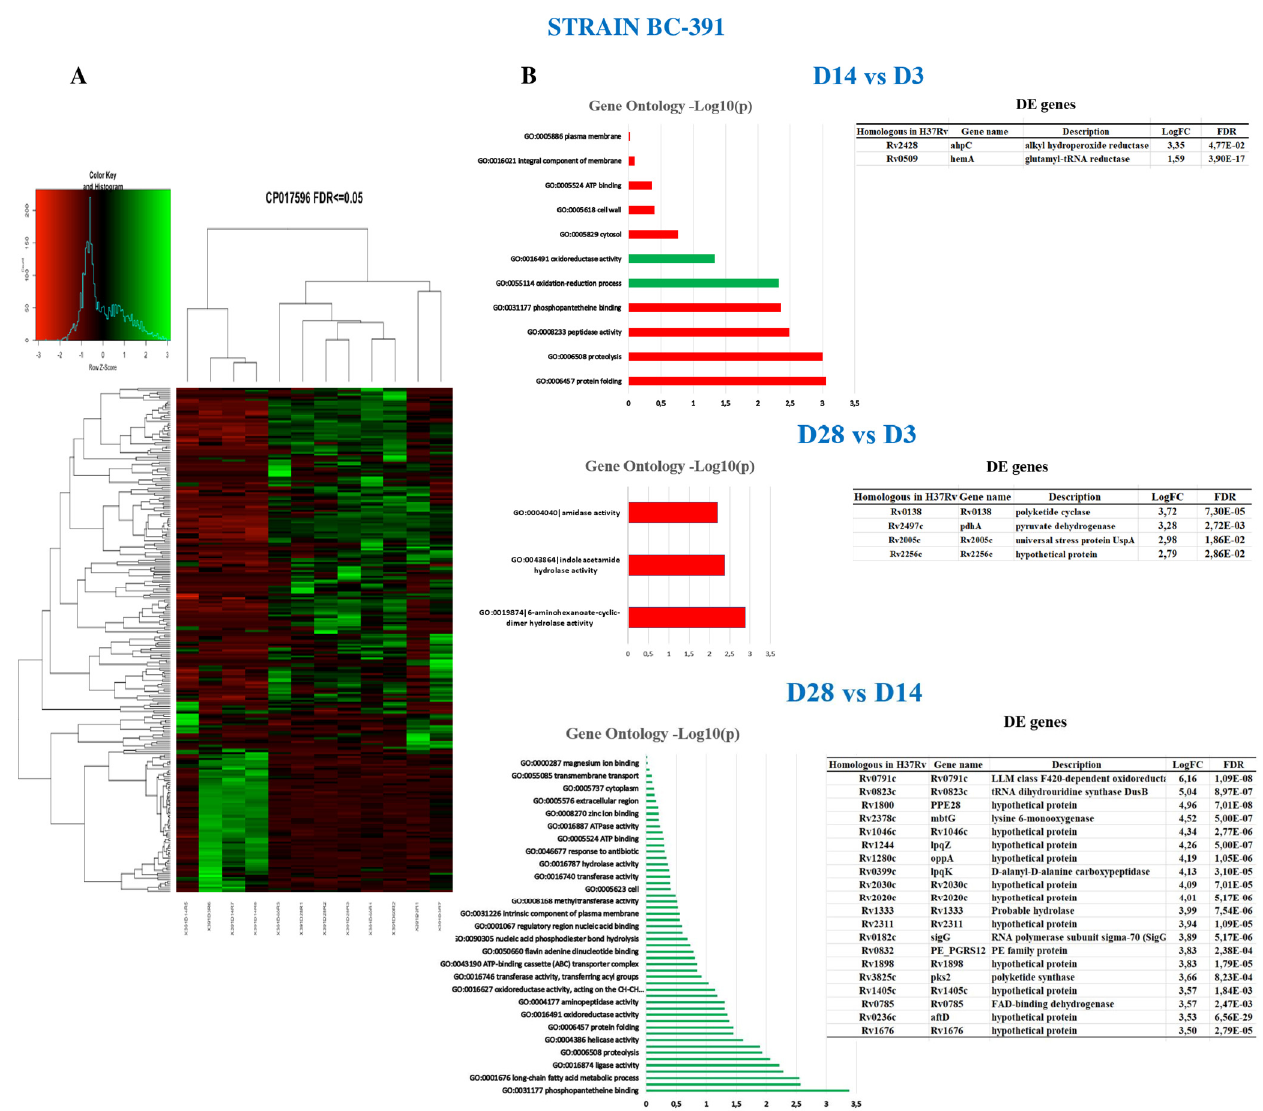
Figure 3. MTB strain BC-391 gene expression differences between days PI. ( A ) Heatmap showing the differentially expressed genes. Overexpressed genes are colored in green whilst under-expressed ones are colored in red. Three biological replicates were included in the analysis. ( B ) GOA at the different time points of the analysis ( p -value ≤ 0.05). Green bars are the enriched metabolic pathways, while red bars are underrepresented. The overexpressed genes are displayed in the tables. D60 vs. D28 is not presented because only one gene was